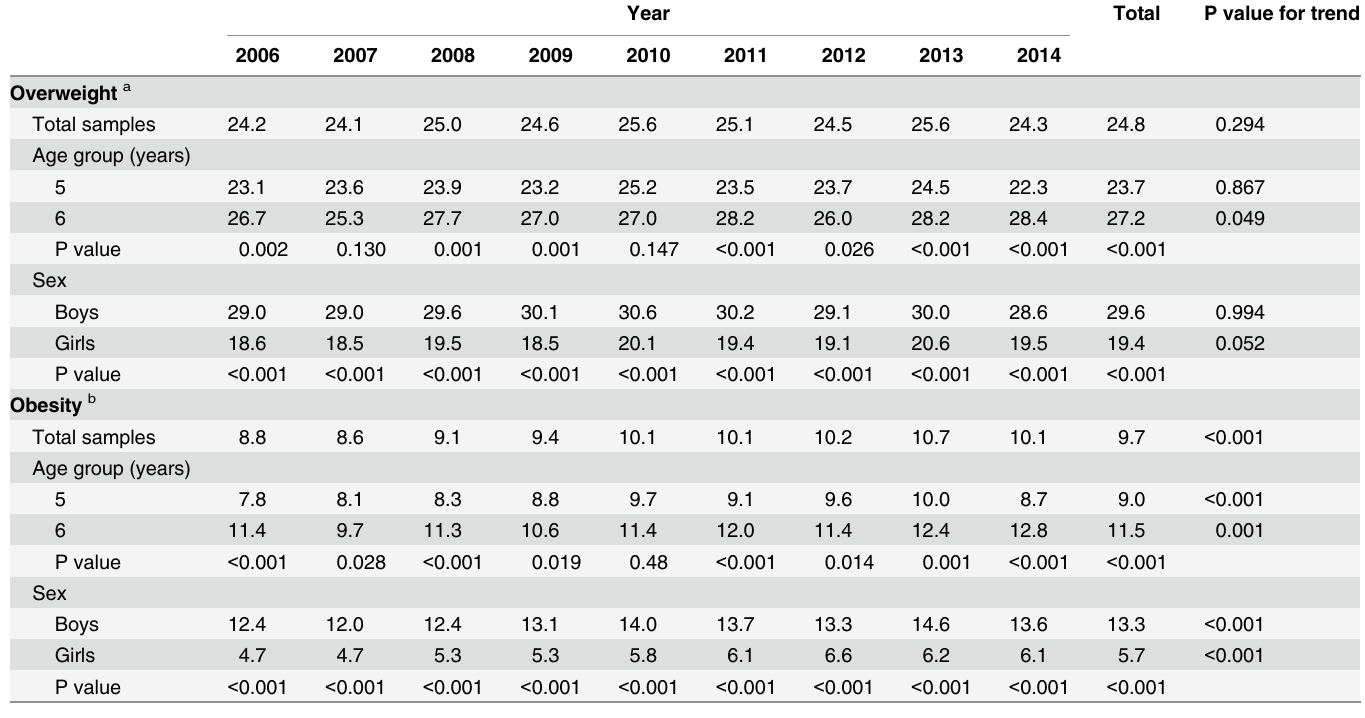
Table 4. Prevalence of overweight and obesity in the children at 5 – 6 years old in Tianjin from 2006 to